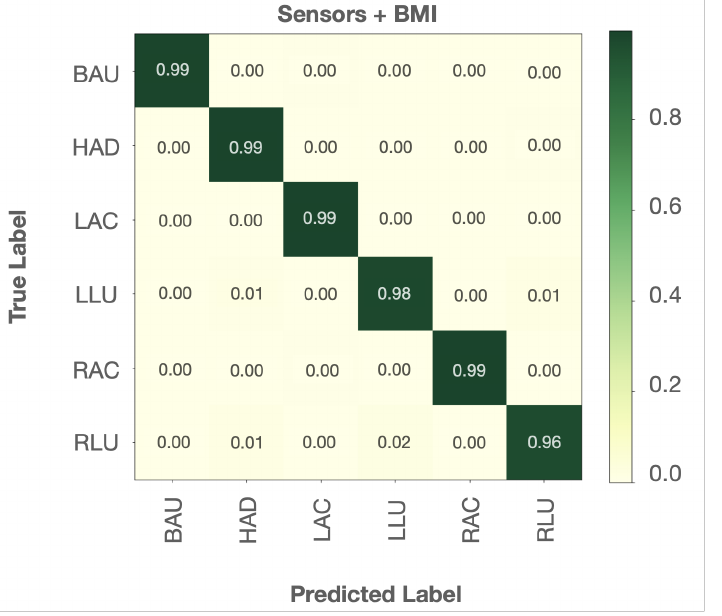
Figure 9. Normalized confusion matrix for the Random Forest classifier in the stretch pose recogni- tion